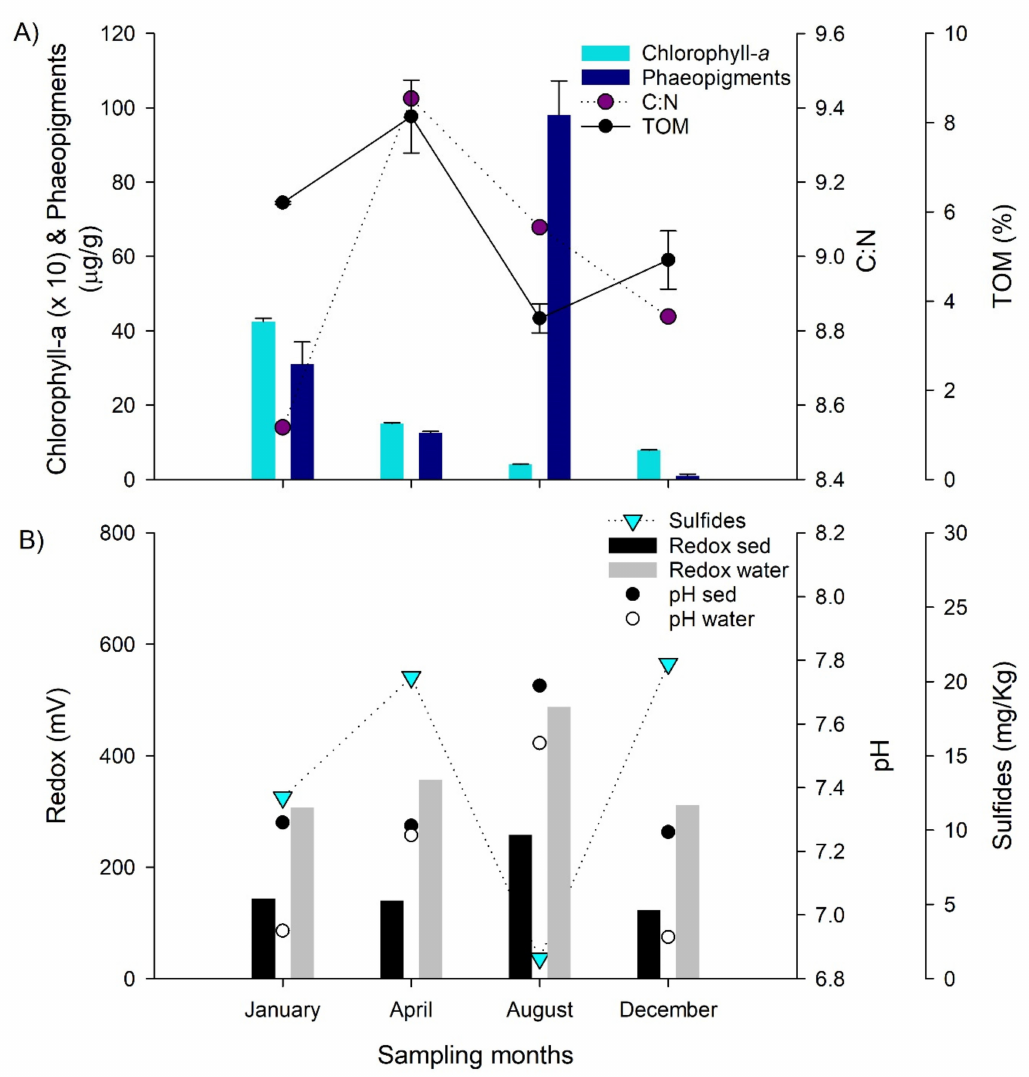
Figure 5. ( A ) Sediment organic matter content and potential quality indicators. ( B ) Sediment total sulfides concentration, redox and pH conditions in surface sediments and overlying water (benthic boundary